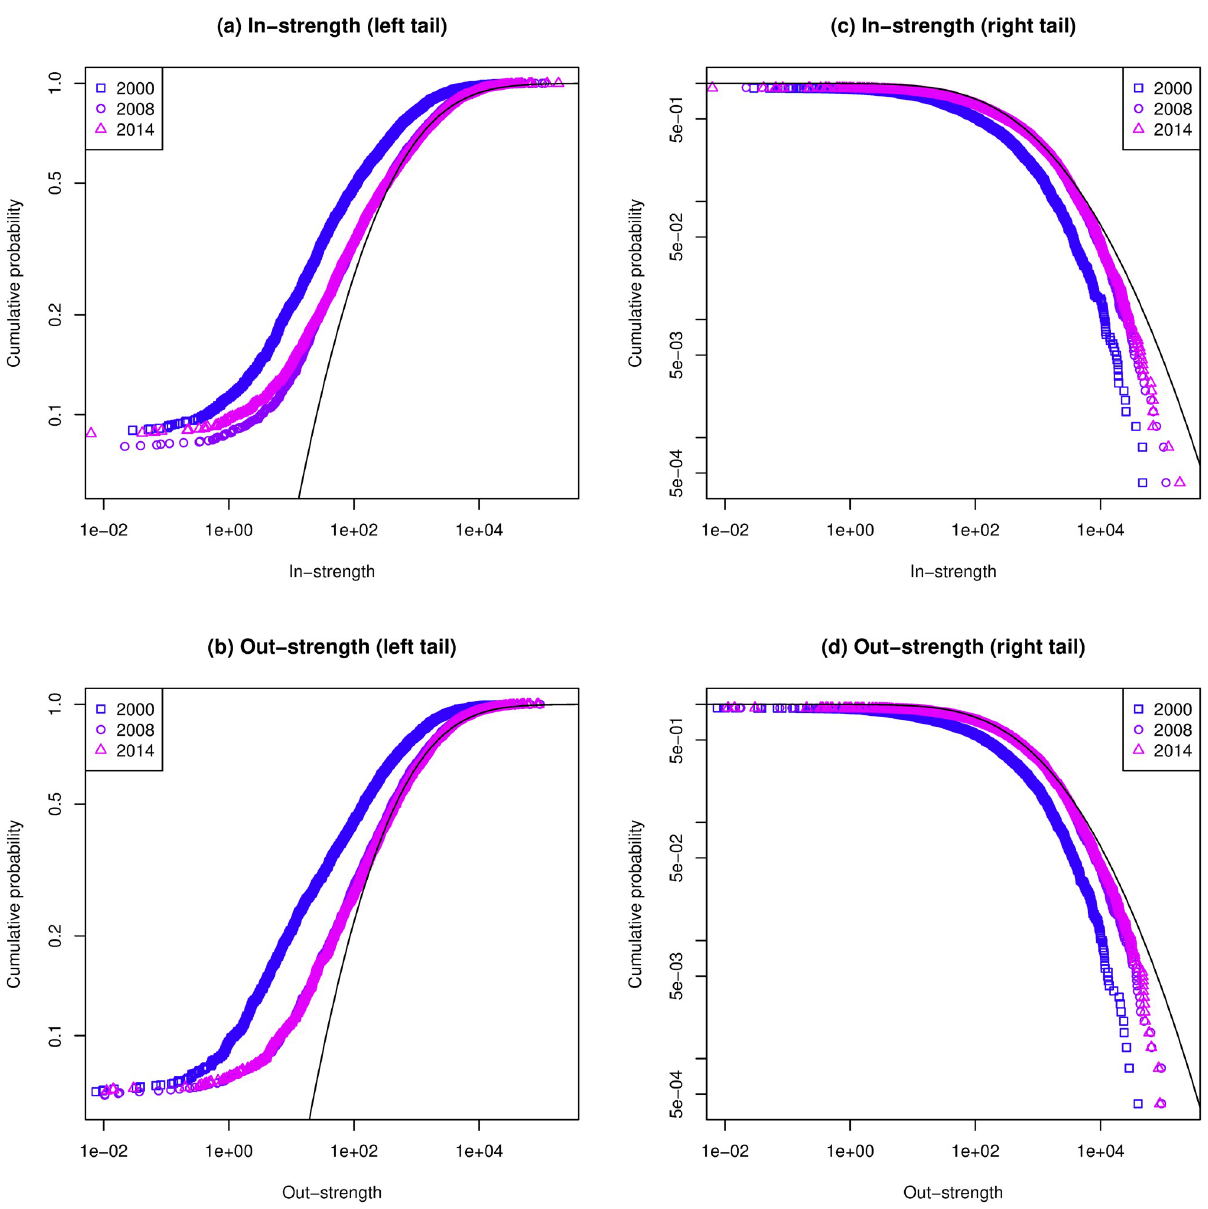
Fig 4. Cumulative probability of strength of IVAN in 2000, 2008, and 2014. The black lines are plots of the cumulative density function of the log- normal distribution whose μ and σ are equal to the average and the standard deviation, respectively, of the logarithm of strength distribution in 2014. Their right tails are almost fitted, but the left tails are not, especially at the